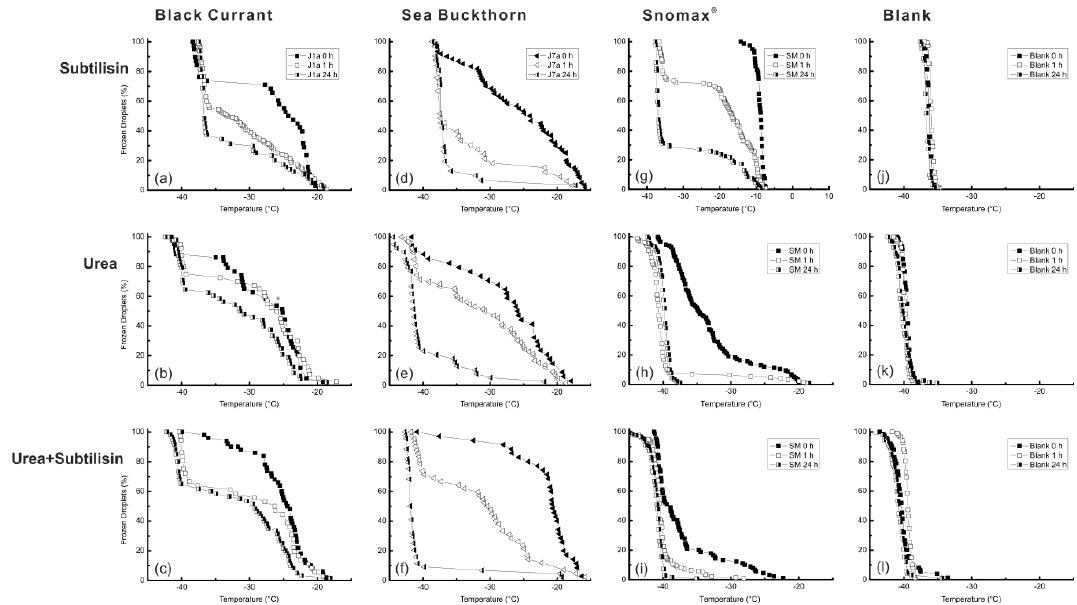
Figure 5. Results of the urea and subtilisin treatments from left to right of black currant juice ((J1a) ( a – c )), sea buckthorn juice (J7a ( d – f )), Snomax ® (SM ( g – i )), and the blanks (blank ( j – l )) shown as fraction of frozen droplets in relation to the temperature. Filled symbols correspond to the sample solutions prior treatment, hollow symbols to the sample after 1 h of treatment in a shaker at 60 ◦ C, and half-filled symbols to the sample after 24 h of treatment. The treatment with subtilisin are shown in the top row ( a , d , g , j ), the treatment with urea are shown in the middle row ( b , e , h , k ), and the treatment with urea and subtilisin is shown in the bottom row ( c , f , i , l ). All depicted samples were diluted 10 fold with ultrapure water prior to